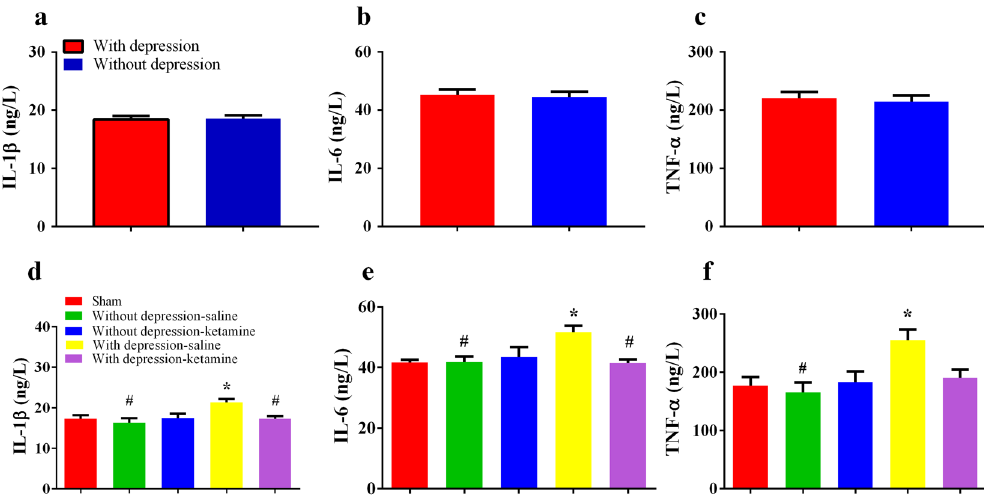
Figure 5. Serum levels of pro-inflammatory cytokines. Serum levels of ( a ) IL-1 β , ( b ) IL-6 and ( c ) TNF- α at baseline were not different between rats with or without depression-like phenotype. Saline-treated rats with depression-like phenotype displayed higher serum levels of ( d ) IL-1 β , ( e ) IL-6 and ( f ) TNF- α compared with sham-operated rats and rats without depression-like phenotype. A single dose of ketamine (20 mg/kg) reduced the serum levels of IL-1 β and IL-6 in the rats with depression-like phenotype. * P < 0.05 vs with sham group, # P < 0.05 vs depression-saline